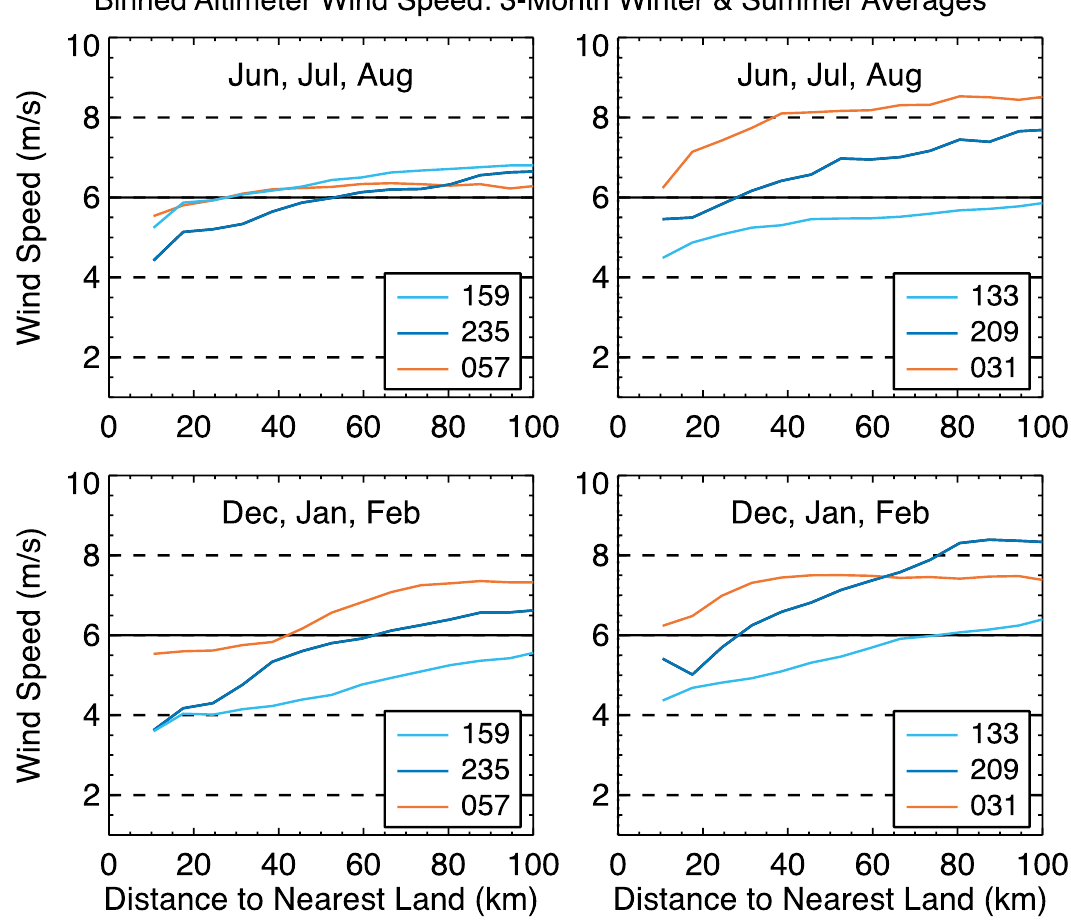
Figure 4. As in Figure 3, except the altimeter wind speed retrievals are averaged into 7-km bins based on the distance to the nearest land.